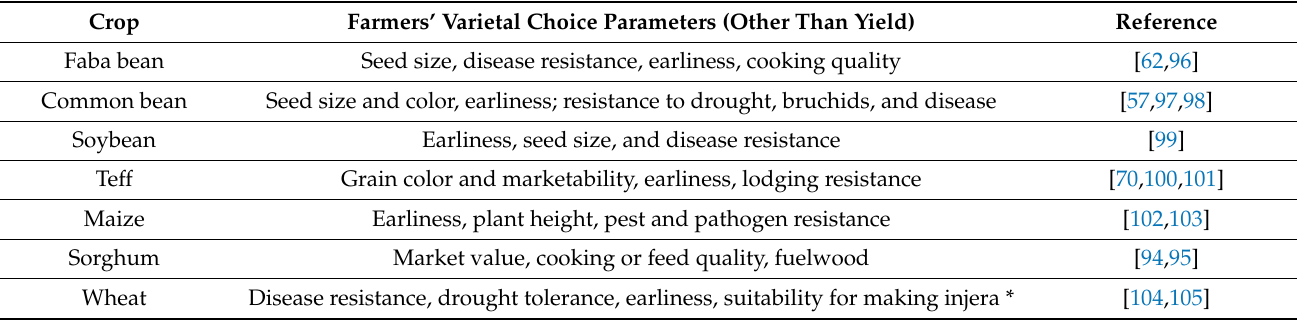
Table 4. Traits governing varietal choice among Ethiopian